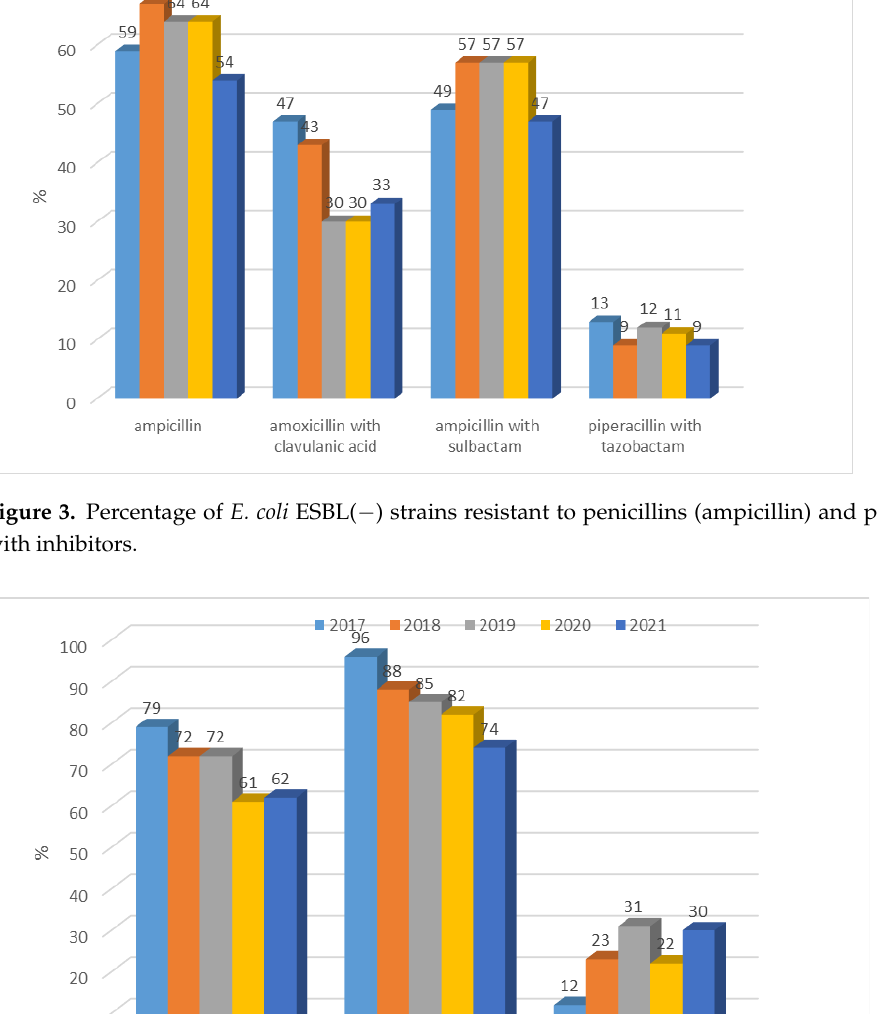
7 of 26 Figure 2. Comparison of the percentage of E. coli ESBL(+) and ESBL(−) strains from 2017 to 2021. Due to the natural resistance of E. coli to penicillin G, only the resistance of strains to semisynthetic penicillins (ampicillin) and penicillins with inhibitors was analyzed. Among E. coli ESBL(−) strains, relatively, there was the highest resistance to ampicil- lin, i.e., from n = 377 (54%; 2021) to n = 538 (67%; 2018). In addition, lower resistance of these strains to amoxicillin with clavulanic acid was observed from n = 197, n = 230 (which is 30%; 2018, 2019 respectively) to n = 343 (47%; 2017) and slightly higher resistance to ampicillin with sulbactam from n = 328 (47%; 2021) to n = 375–458 depending on the year (57%; 2018–2020). E. coli ESBL(−) strains showed the greatest susceptibility (over 85%) to piperacillin with tazobactam. For E. coli ESBL(−) strains, when comparing resistance to penicillins (ampicillin) and penicillins with inhibitors in each year separately, resistance significantly differs in each year ( p < 0.001). In-pairs comparisons (post-hoc) show that in every year, there was a significant difference between resistance to each ampicillin vs. pip- eracillin with tazobactam ( p < 0.001). In 2017, there were no significant differences between other pairs. In 2018, a significant difference between ampicillin and amoxicillin with clavu- lanic acid ( p < 0.01) was noticed. In 2019 and 2020, there was a significantly better response